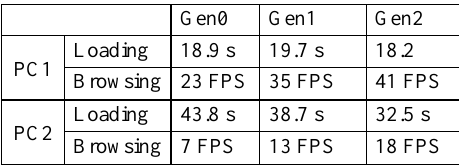
Table 3 . Time of the loading and